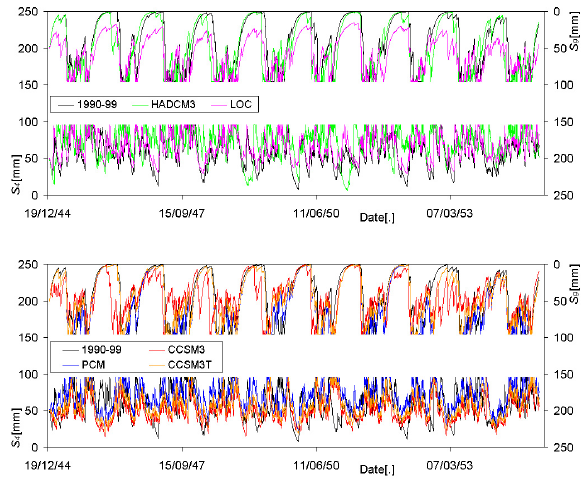
Fig. 8. Oglio at Sarnico. Scenario simulations, period 2045– 2054. S at belts 4 (1225ms.l.m.) and 9 (2975ms.l.m.). (a) LOC, HadCM3. (b) PCM, CCSM3, CCSM3T.